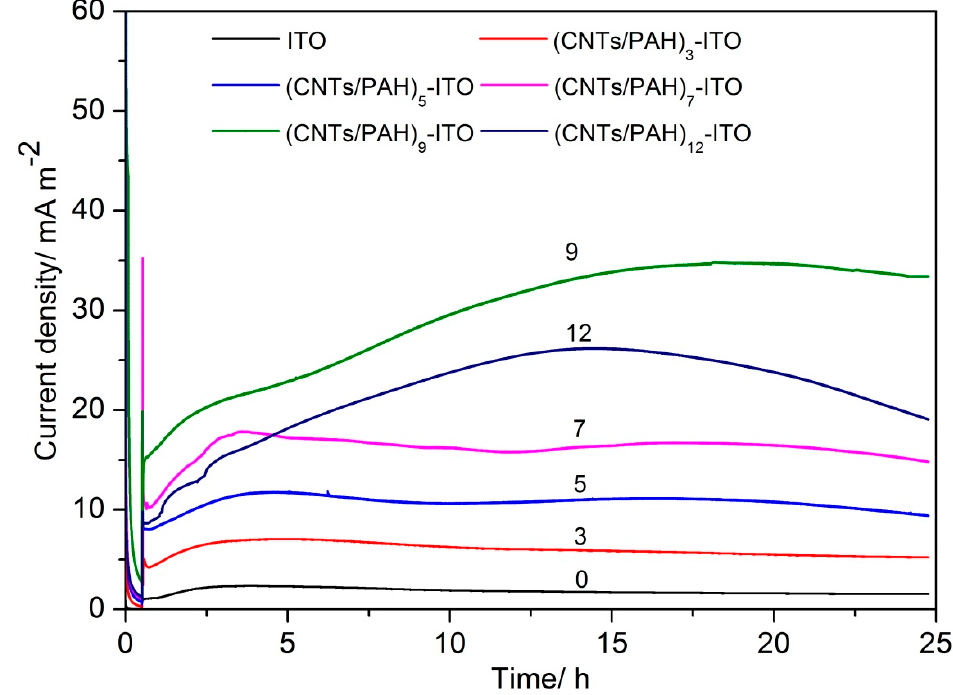
Figure 3. Evolution of current density with time generated by S. loihica PV-4 on the (CNTs/PAH) n - deposited ITO electrode (n = 0, 3, 5, 7, 9, 12) poised at 0.2